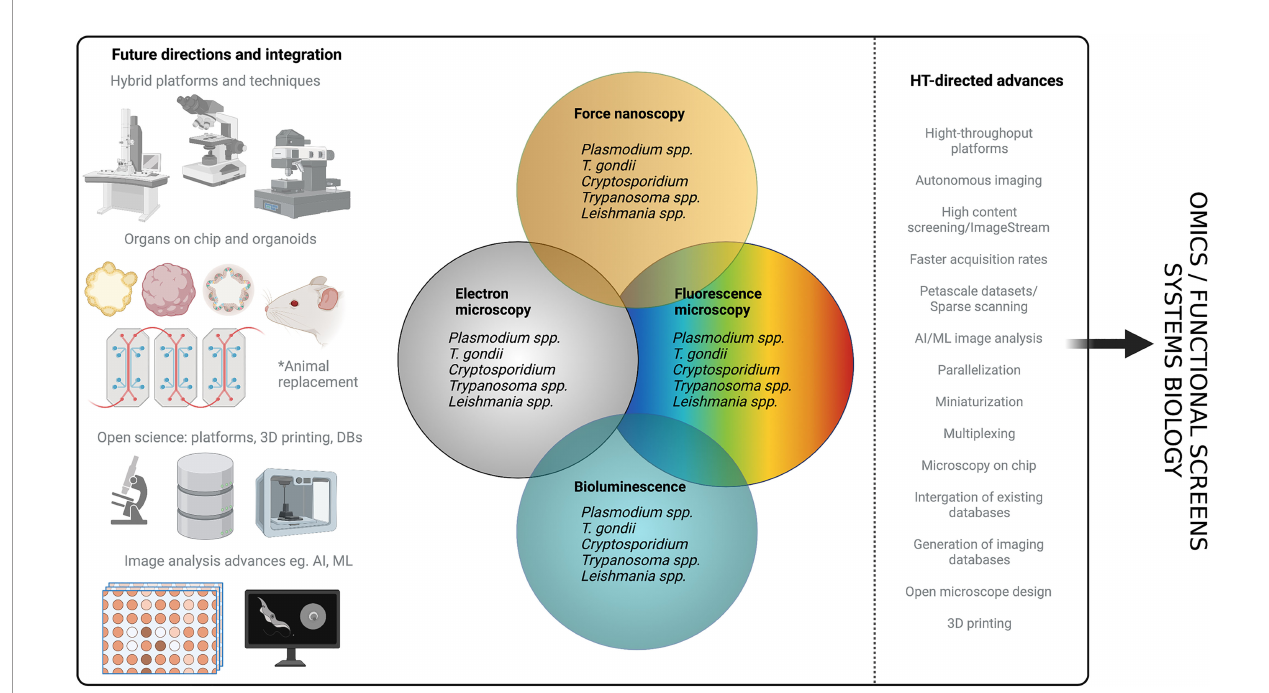
FIGURE 10 | Microscopy current contributions and future directions. Multiple imaging modalities, including electron microscopy, fl uorescence microscopy, bioluminescence, and force nanoscopy, have been extensively used in Apicomplexan and Kinetoplastid research. Efforts on technology development have led to the generation of hybrid imaging platforms (eg. combining electron and fl uorescence microscopy in CLEM); the integration of cell culture, micro fl uidics, and bioengineering advances (eg. organoids and organs-on-chip, consistent with animal replacement and reduction) with imaging methods; the integration of 3D printing and robotics for the generation of versatile imaging platforms, including high-content imaging; and the integration of arti fi cial intelligence for image analysis. Many of these improvements are consistent with a philosophy of open science, and have facilitated data-sharing and the creation of low-cost complex imaging equipment. Most of these have already been incorporated into parasitology research, but not in high-throughput modalities. Efforts towards increasing the throughput of conventionally low-throughput techniques are shown on the left column, and include autonomous imaging (whereby user input is not required, reducing human resource demands), miniaturization and parallelization, multiplexing, and faster acquisition methods. Equally, a bottleneck for microscopy-based research is image analysis. Incorporation of arti fi cial intelligence and machine learning, and integration with open databases and open code are promising fi elds for parasitology. Together, these various elements will likely play a major role on the integration of imaging into ‘ omics ’ studies to understand parasite biology. Figure created with